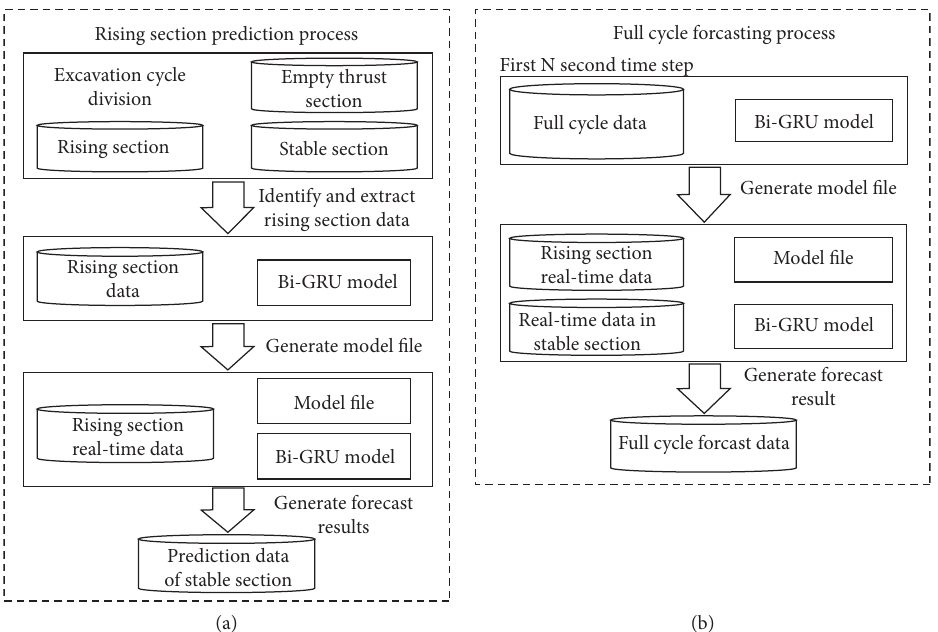
Figure 8: Comparison of complete tunneling cycle and ascending section. (a) Ascending segment prediction. (b) Full-period prediction.